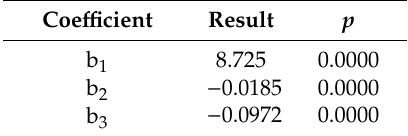
Table 4. The results of the regression analysis.